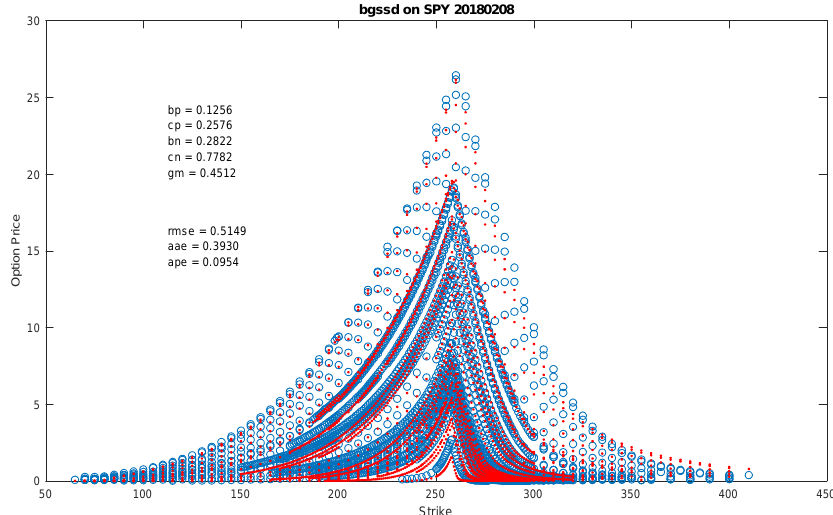
Figure 5. Fit of bgssd to SPY options as at 8 February 2018. Shown by circles are the out of the Figure 5: Fit of bgssd to SPY options as at February 8, 2018. Shown by circles money market prices for the 2695 across 28 maturities. The dots represent the calibrated model prices. are the out of the money market prices for the 2695 across 28 maturities. The Also presented are parameter values and fit dots represent the calibrated model prices. Also presented are parameter values and (cid:133)t statistics.